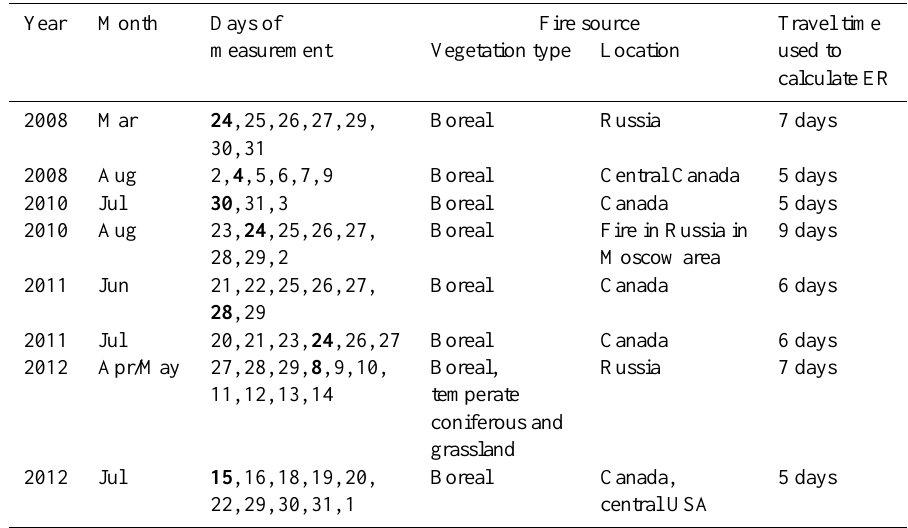
Table 2. Same as Table 1 but for